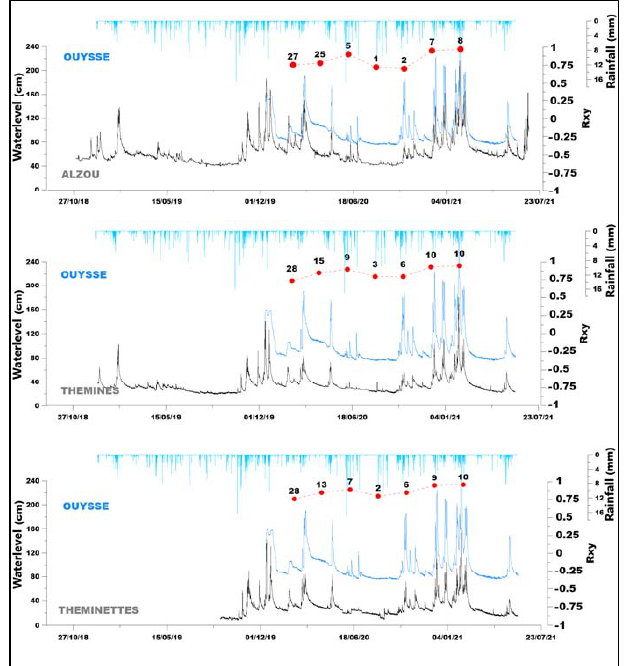
Figure A2. Sliding correlation analyses between the water level for the Ouysse station and the different stations at the sinks; the results of the sliding cross-correlation analyses are displayed in red dots (vertical axis: correlation, label: time lag between the two sites in hours). Water 2023 , 15 , x FOR PEER REVIEW